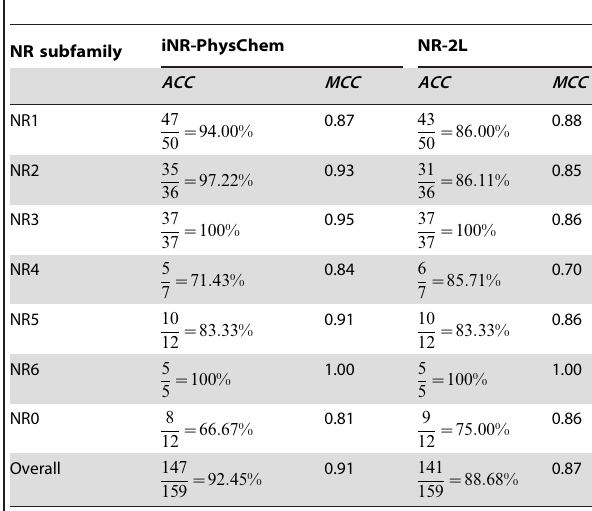
Table 4. Comparison of the success rates and MCC values obtained by the current iNR-PhysChem and NR-2L [16] in identifying the subfamilies of NRs by the jackknife test on the benchmark dataset S NR (cf. Eq. 1 ).